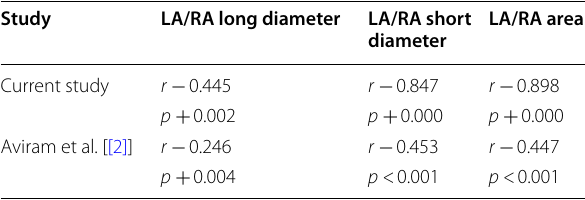
Table 7 Correlation between the PAOI and LA/RA radiologic parameters in current study and study by Aviram et